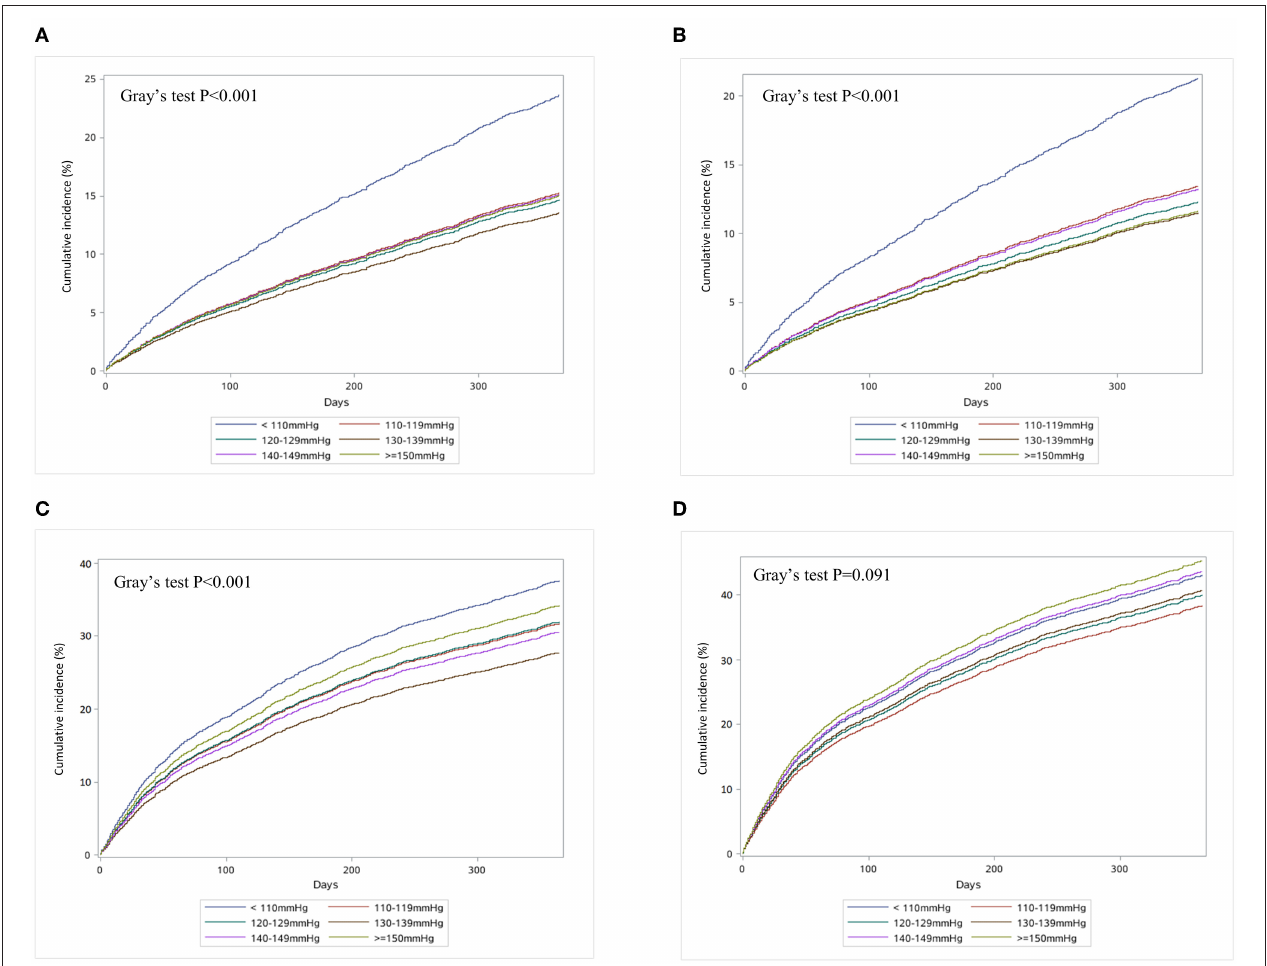
FIGURE 1 | Cumulative incidence curves for all-cause death (A) , heart failure readmission (B) , cardiovascular death (C) , and all-cause hospitalization (D) in patients hospitalized for heart failure. This study assessed the association of systolic blood pressure with clinical outcomes in patients hospitalized with heart failure. Patients were categorized into six groups by systolic blood pressure ( < 110, 110–119, 120–129, 130–139, 140–149, and ≥ 150 mmHg) for analysis.